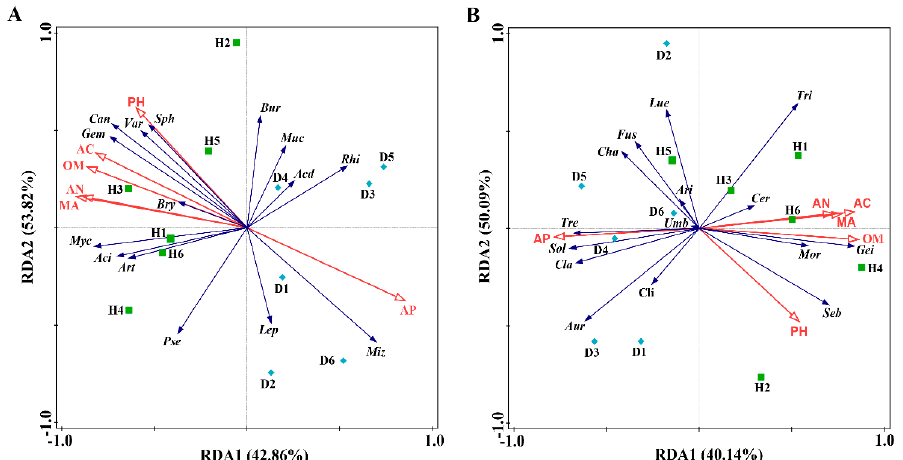
Figure 4. Redundancy discriminant analysis (RDA) of the rhizosphere bacterial ( A ) and fungal ( B ) community compositions at genus levels with soil physicochemical properties. Aci: Acidothermus ;